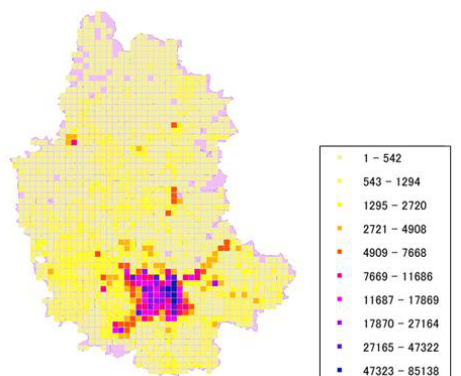
Figure 7. Spatially smoothed population distribution reflecting MODIS land use in Hanoi.